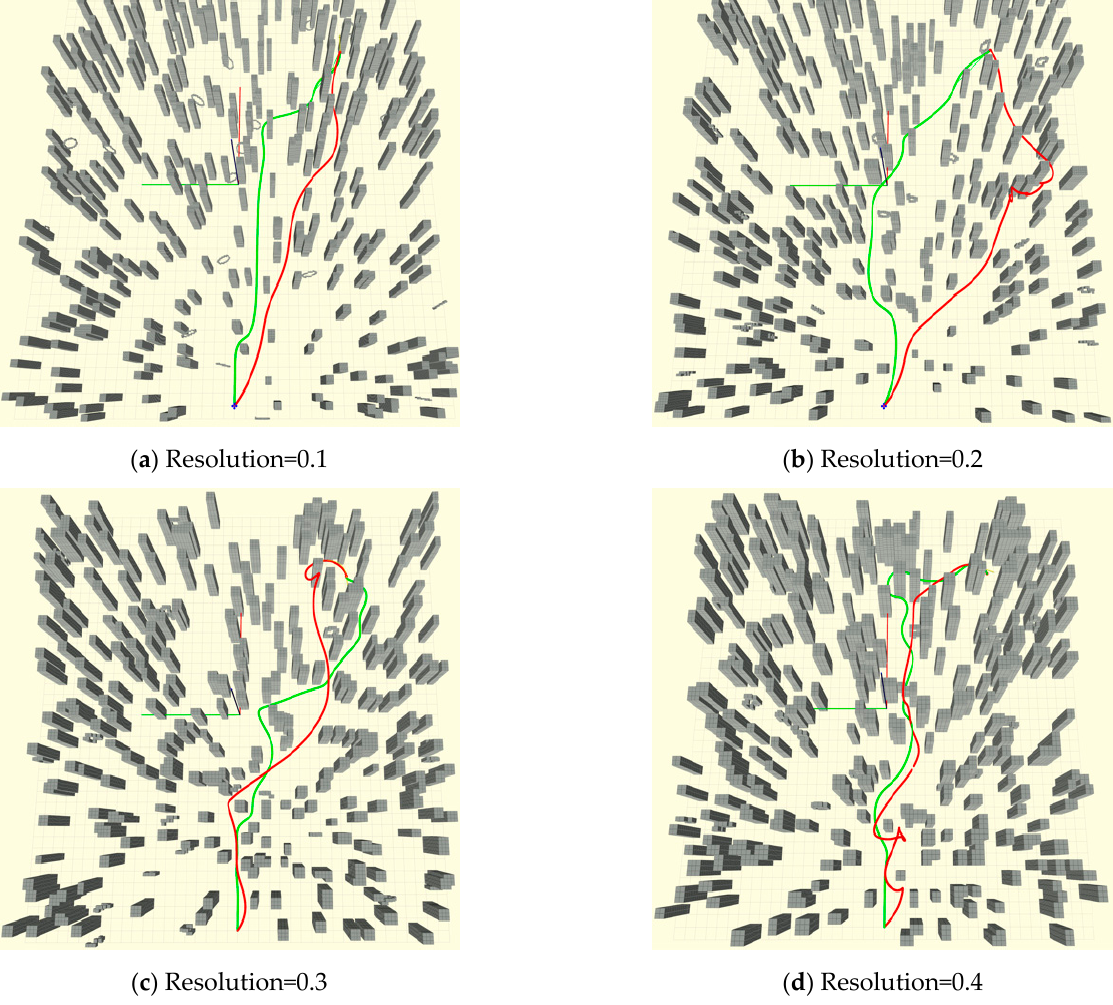
Figure 11. Samples of the maps and trajectories generated by the proposed method (green) and RET (red) in different resolutions.